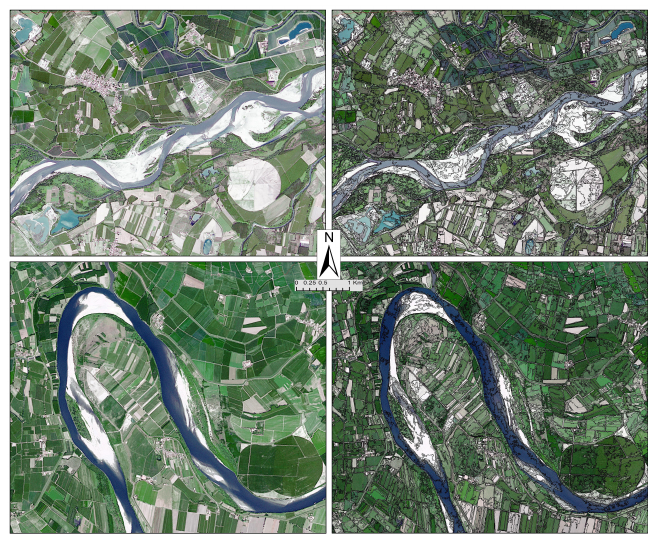
Figure 7. Example of the obtained GEOBIA segmentation along di ff erent river sections.